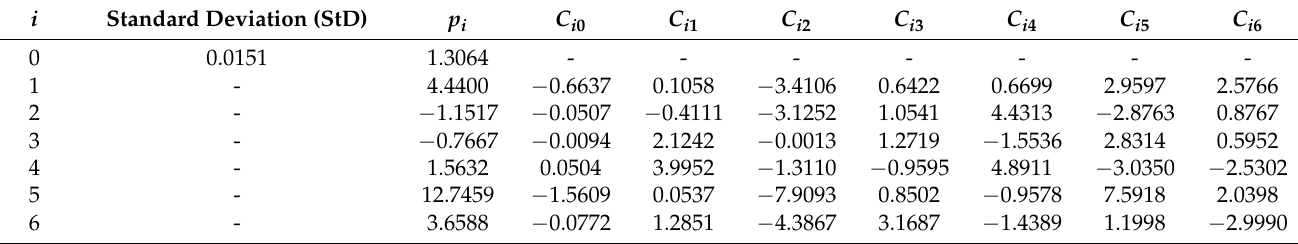
Table 2. Coefficients for formulation of the cantilever wall deflection δ N